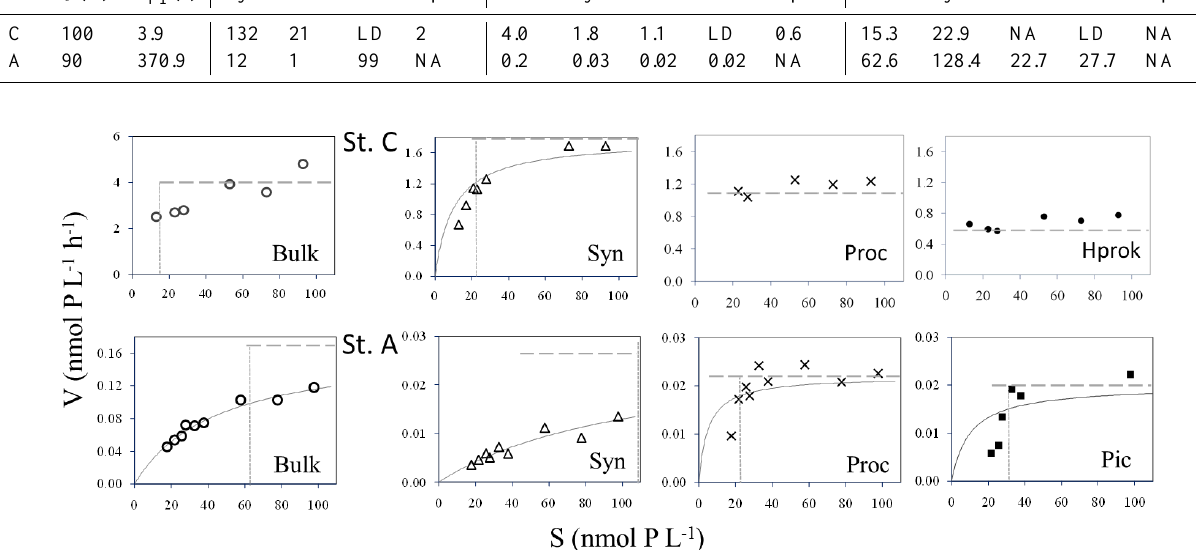
Figure 5. Bulk and taxon-specific Pi uptake rates ( V ) at increasing Pi concentrations (in situ + added) in sorted Synechococcus (Syn), Prochlorococcus (Proc), picophytoeukaryotes (Pic) and heterotrophic prokaryotes (Hprok) at St. A and C. Straight horizontal and vertical lines represent computed V max and K + S n , respectively. If a significant correlation ( p <0.05) between measured Pi uptake rates and those calculated from the Michaelis-Menten model occurred, the uptake curve was fitted to the